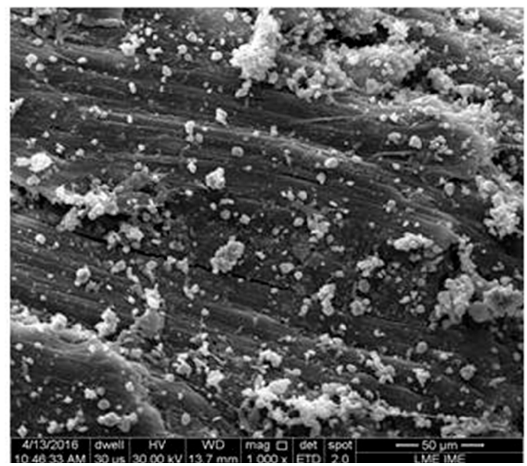
Figure 6. SEM of the fracture surface of 30 vol % jute fabric composite covered with ceramic fragments.